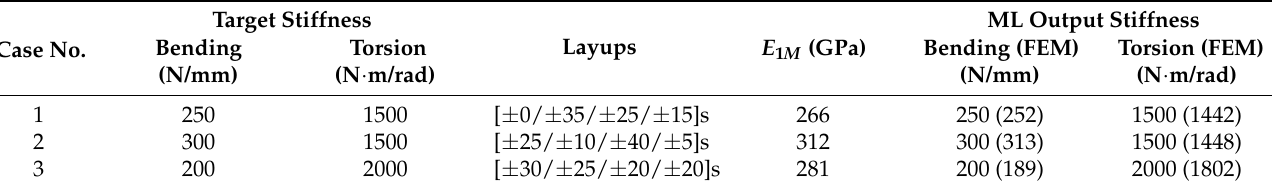
Table 3. The optimal layups and the modulus design under several stiffness requirements.